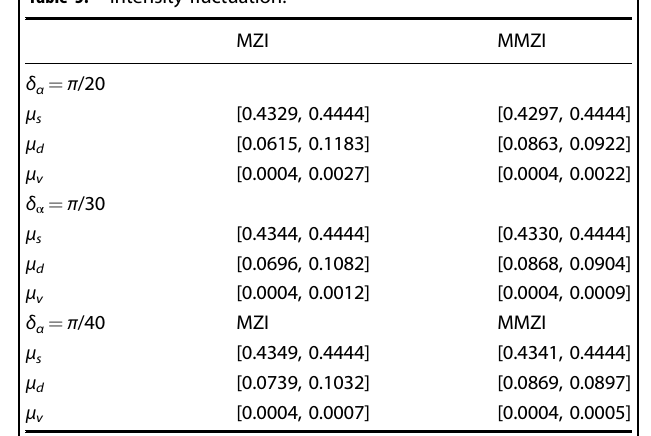
Table 3. Intensity fl uctuation.